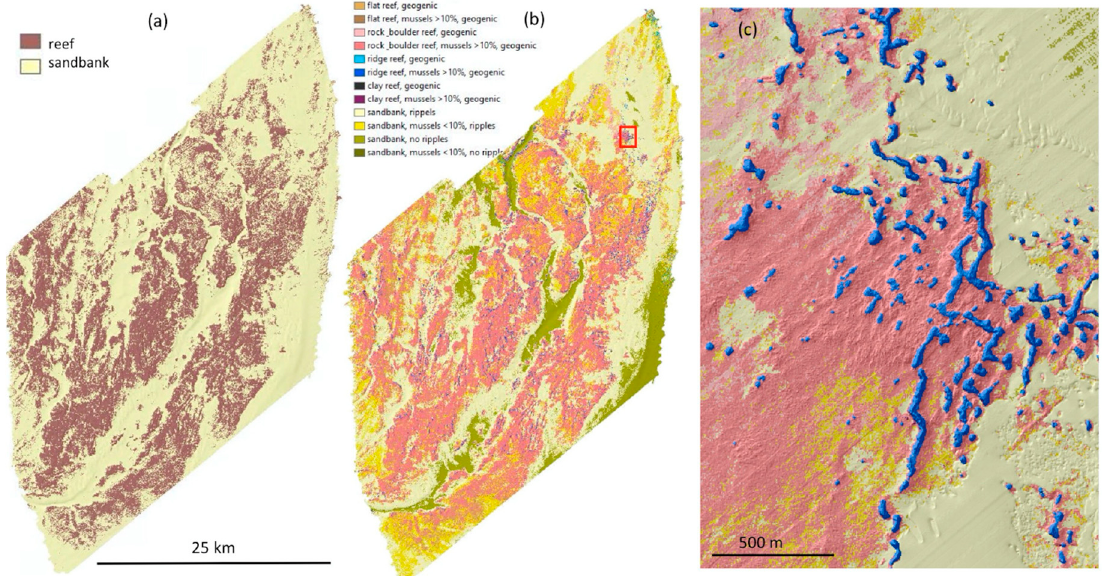
Figure 11. ( a ) Natura 2000 reefs and sandbanks, ( b ) Natura 2000 subtypes according to the Geological Survey of Sweden (SGU) implementation, ( c ) zoom of ( b ). The Natura 2000 subtypes were developed through a combination of continuous substrate and biological predictions, terrain metrics (i.e., fine-scale bpi) and thematic models (i.e., ripples or no ripples).